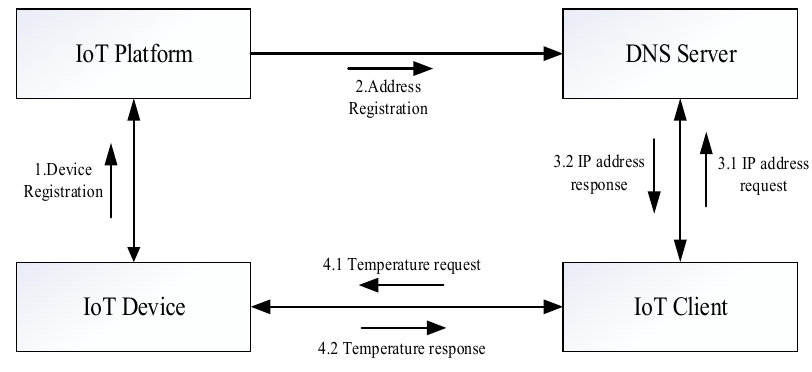
Figure 4. Collaboration diagram of the proposed system.